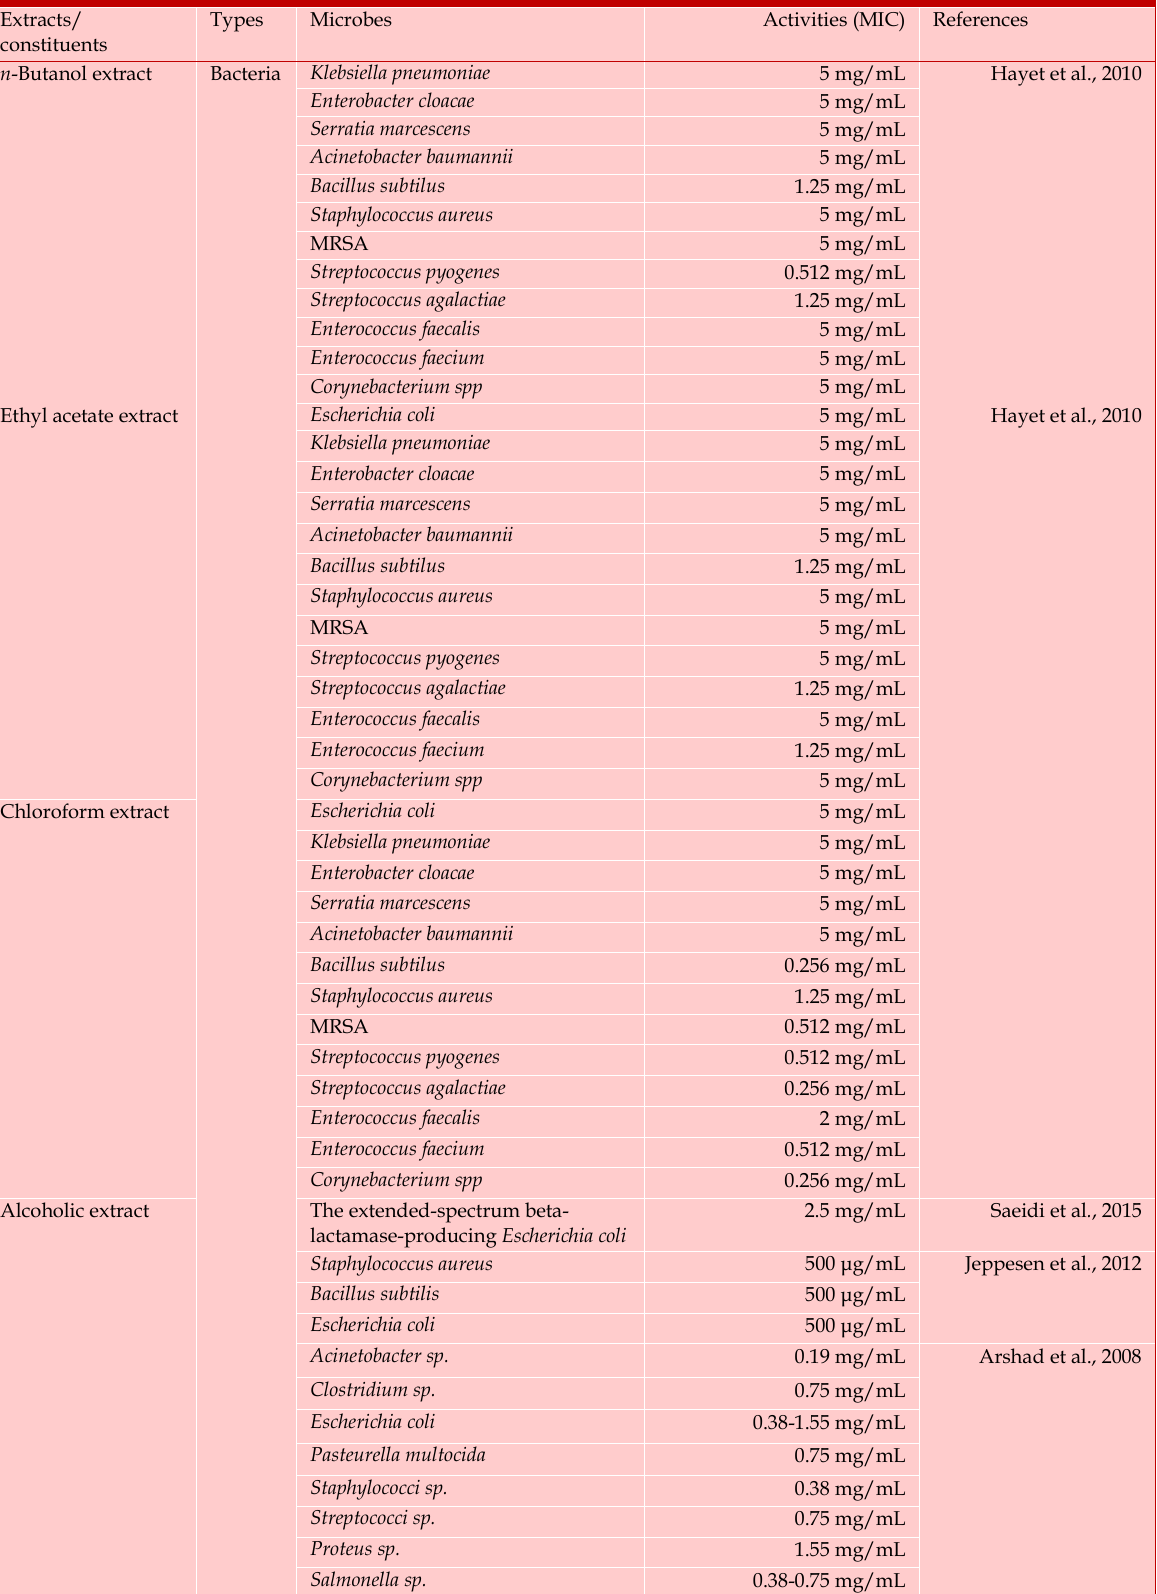
Antimicrobial activities of Peganum harmala